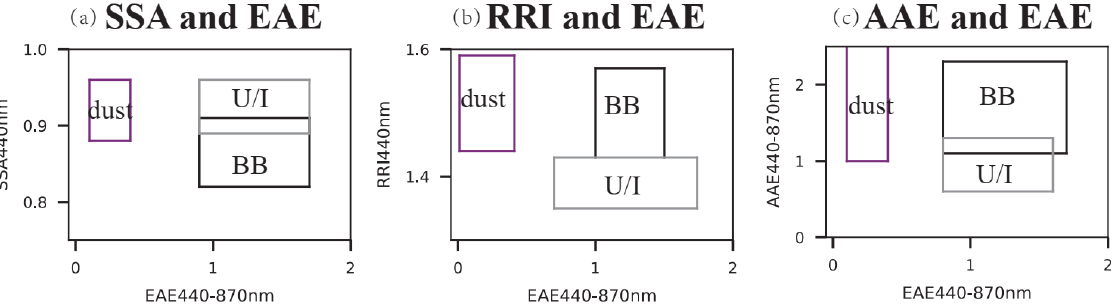
Figure 2. Schematic diagram of the 2 ‐ D clustering approaches: ( a ) using SSA and EAE; ( b ) using RRI and EAE; ( c ) using AAE and EAE.